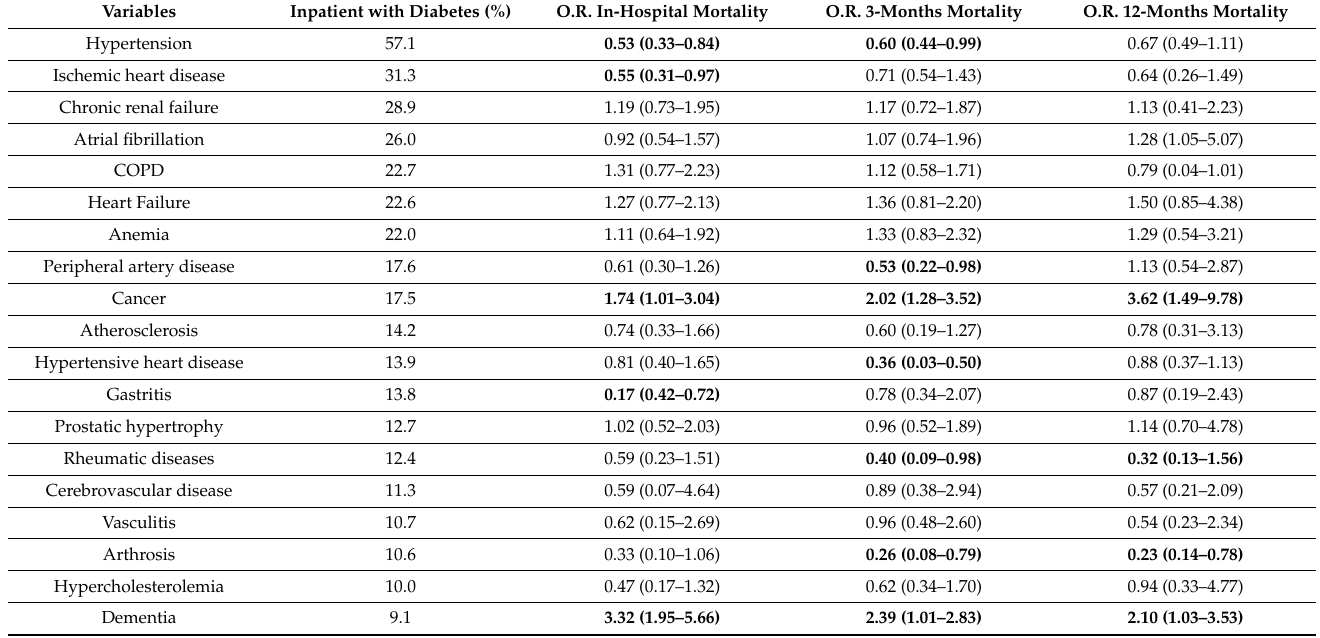
Table A1. Univariate